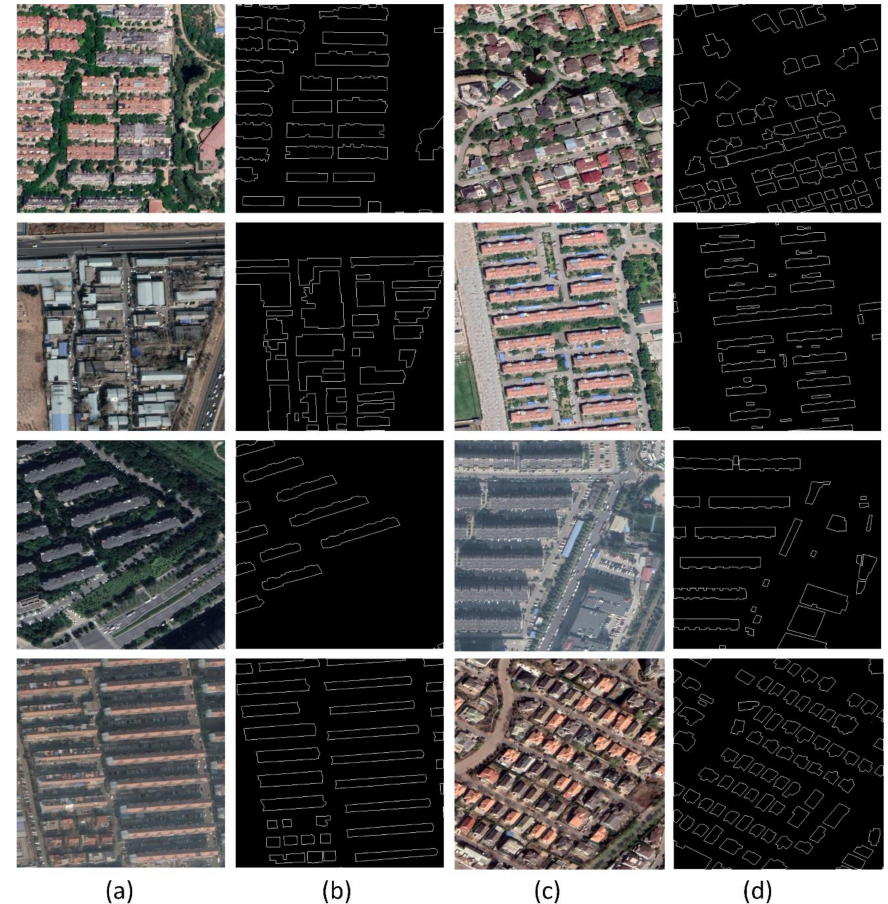
Figure 4. Example images from the building dataset taken in Beijing from Google Earth. ( a ) Original image for training and testing, ( b ) edge labels of ( a ), ( c ) original image for generalization ability testing and ( d ) edge labels of ( c